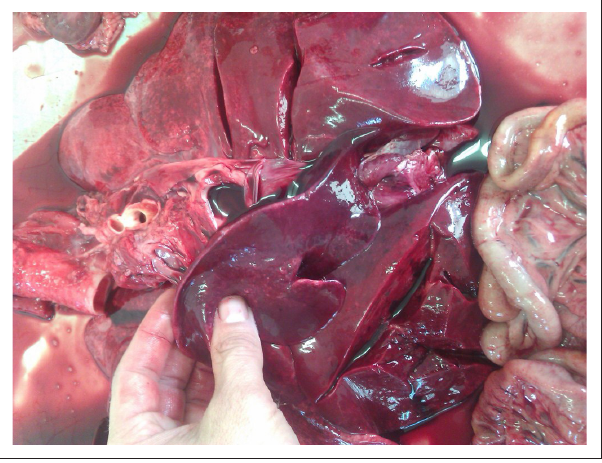
FIGURE 3: Severe diffuse congestion, oedema and red hepatisation of the